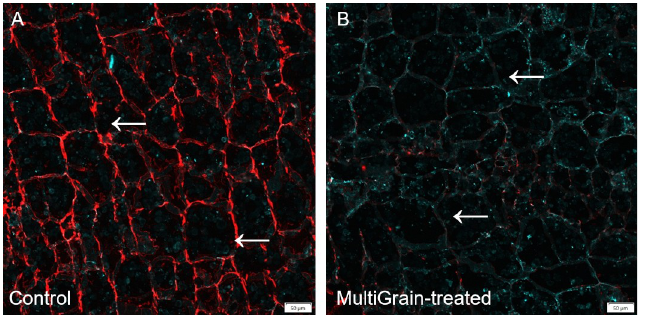
Fig 9. Confocal images of cross sections of whole cassava root. Sections of sample incubated with (A) sodium acetate buffer (control) or (B) with MultiGrain for 3 hours at pH 5. Slides were subsequently incubated with the LM25 antibody detecting xyloglucans and the red fluorescence labelled secondary antibody. Red signal indicates xyloglucans with different branching structures and the blue signal indicates autofluorescence from cell walls structures. Arrows point to sites where the fluorescence signal due to staining or immunolabelling is present and removed following treatment with MultiGrain. Scale bar = 50 μ m.